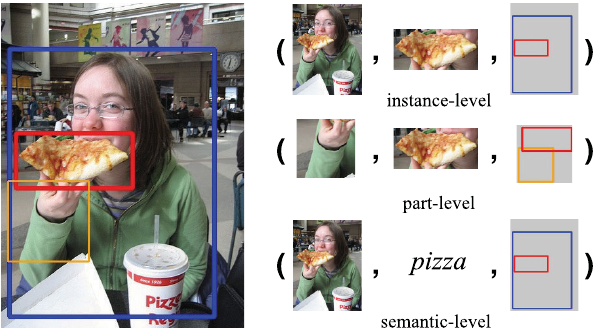
HOI can be characterized using three levels of pairwise features, the instance-, body part-, and semantic-levels. At the part- level, the visually and spatially related hand and object pair indicates hold ; at the semantic-level, the object label pizza strongly suggests eat